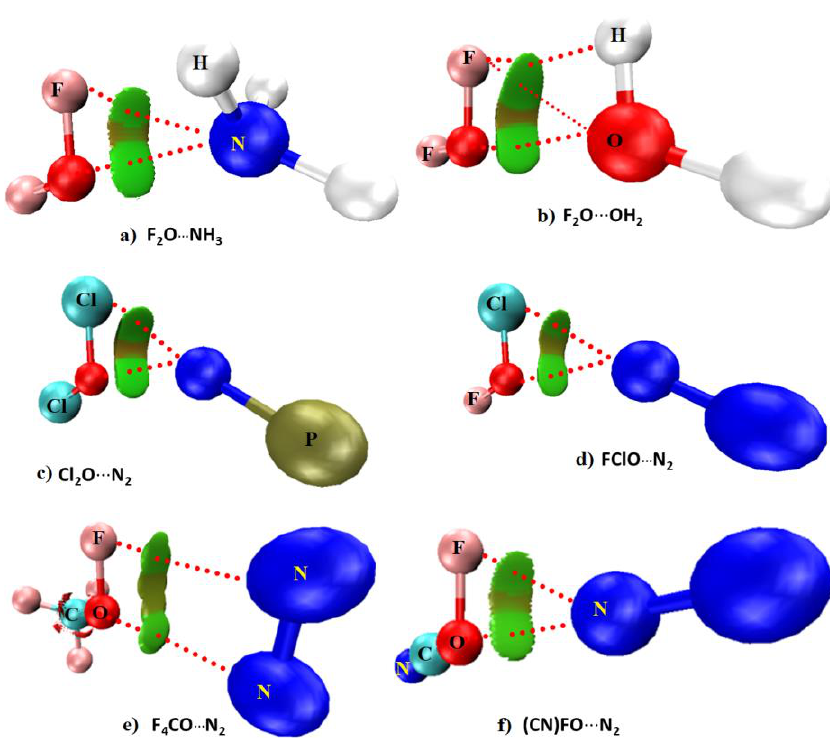
Figure 5. Illustration of the MP2/aug-cc-pVTZ level reduced density gradient (RDG) isosurface plots (0.5 au) for the six chalcogen-bonded complexes examined. The dotted lines in red represent possible intermolecular interactions, whereas the pseudo dumbbell-shaped volumes between the molecules represent the RDG domains. Color of RDG domains: green—weakly bound attractive attractions; brown—van der Waals. Atom labeling is shown.